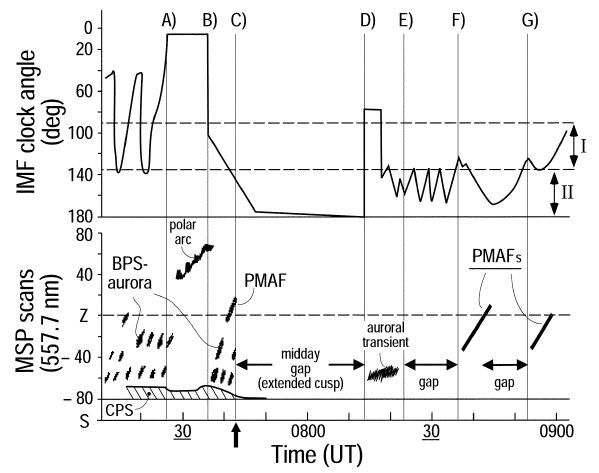
Fig. 13. Schematic overview of the IMF regulation of the green line aurorae, as monitored by the meridian scanning photometer (MSP; see the lower panel). The zenith angle of the MSP records is shown along the vertical axis in the lower panel. North is up. The upper panel shows the essential features of the variability of the IMF clock angle. Clock angle regimes I and II are deliminated by horizontal lines. The interval shown is 07:10–09:00 UT, representing the ∼ 10:00–12:00 MLT